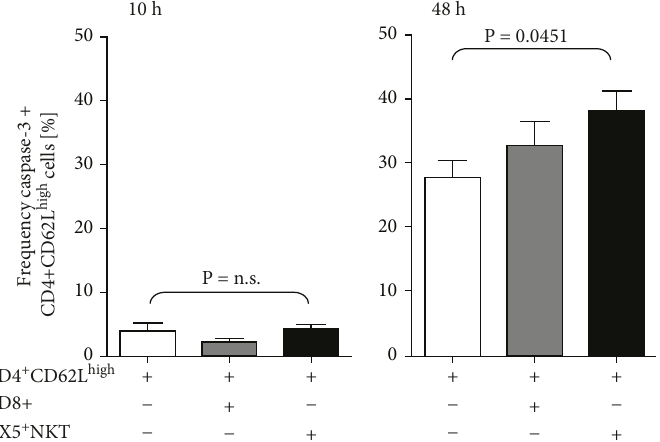
Figure 2: Intracellular fl ow cytometry detection of IFN- γ in CD4 + CD62L high (a) and CD4 + CD62L monoculture or coculture with CD8 + T cells or CD3 + DX5 + NKT. Results are given as mean +SEM. Experiments were repeated at least three times ( ∗ P < 0 05 ).